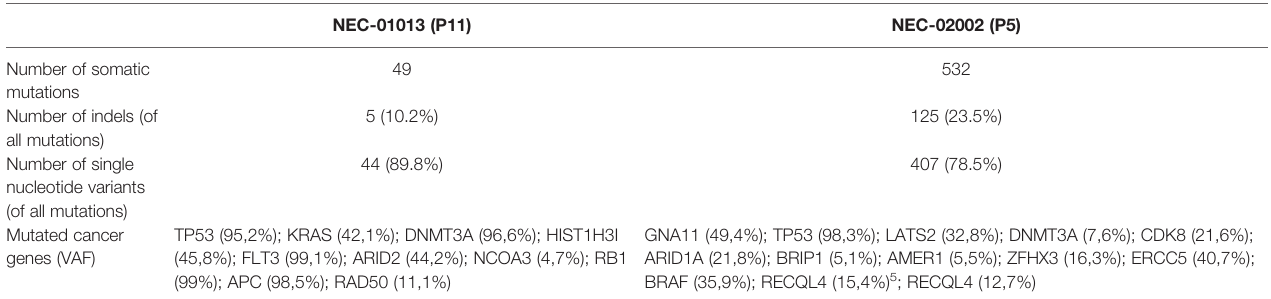
TABLE 2 | Mutations in NEC organoids identi fi ed by whole exome sequencing. 4